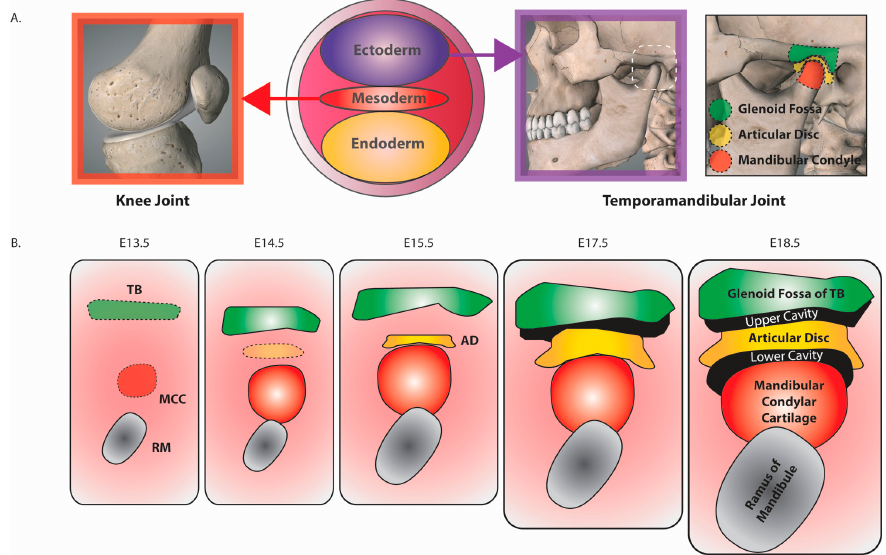
Figure 1. Embryonic origins and development of the temporomandibular joint. ( A ) Appendicular joints like the knee joint are derived from the embryonic mesoderm, whereas the axial temporomandibular joint is derived from the embryonic ectoderm. The boxed region is enlarged to show the location of the mandibular condyle (MC), articular disc (AD) and glenoid fossa (GF). It also corresponds to the developing tissues indicated in ( B ). Please note that the MC contains the cartilaginous region termed the mandibular condyle cartilage (MCC); ( B ) Development of components of the murine temporomandibular joint (TMJ). Approximate embryonic stages are indicated above each panel. This model indicates independent mesenchymal condensations for the temporal bone (TB), mandibular condylar cartilage (MCC) and articular disc (AD)—please see text for controversy concerning the developmental origins of the MCC. Labelled components of the TMJ are indicated at E18.5. Please note that the temporal bone contains the subregion termed the glenoid fossa (GF) and TMJ development continues postnatally (not shown). The capsule that envelops the joint and one major and two minor ligaments associated with the TMJ are not depicted. Figure adapted from Suzuki et al.